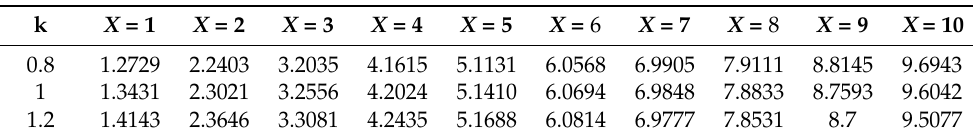
Table 2. Dependence of the value of the function f m ( X ) on the expert error k and the grade X in case 3, when µ = 7.